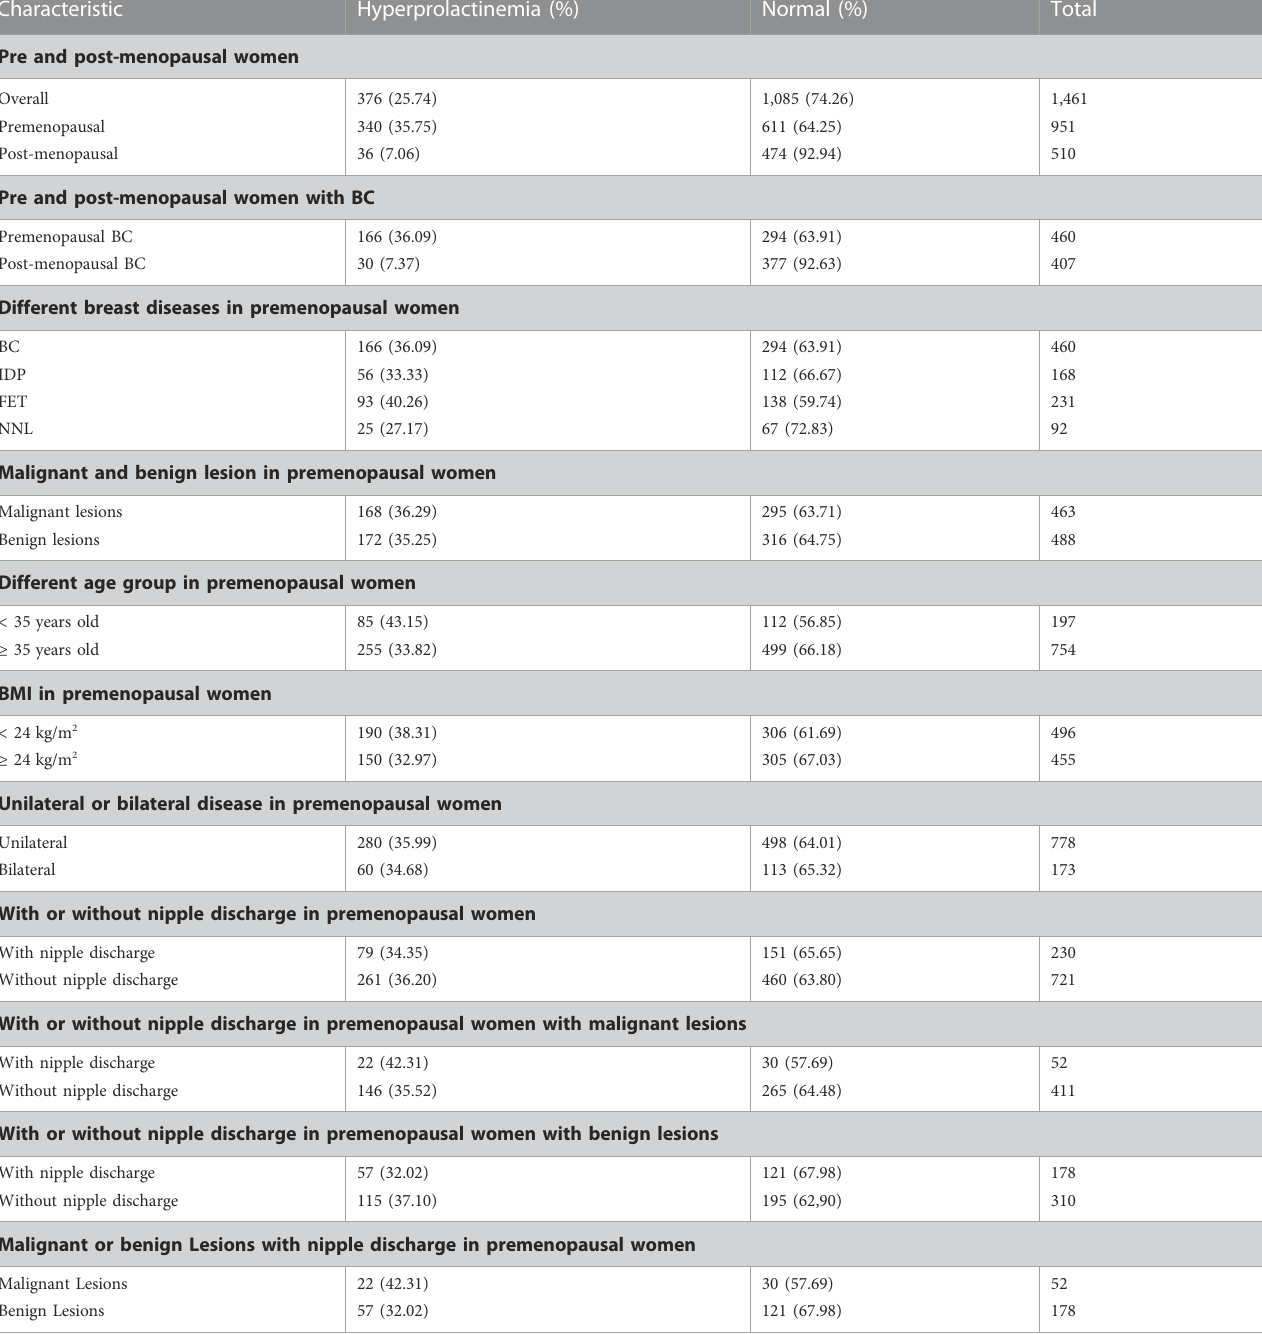
TABLE 3 Consitituent ratio of hyperprolactinemia in premenopausal women.